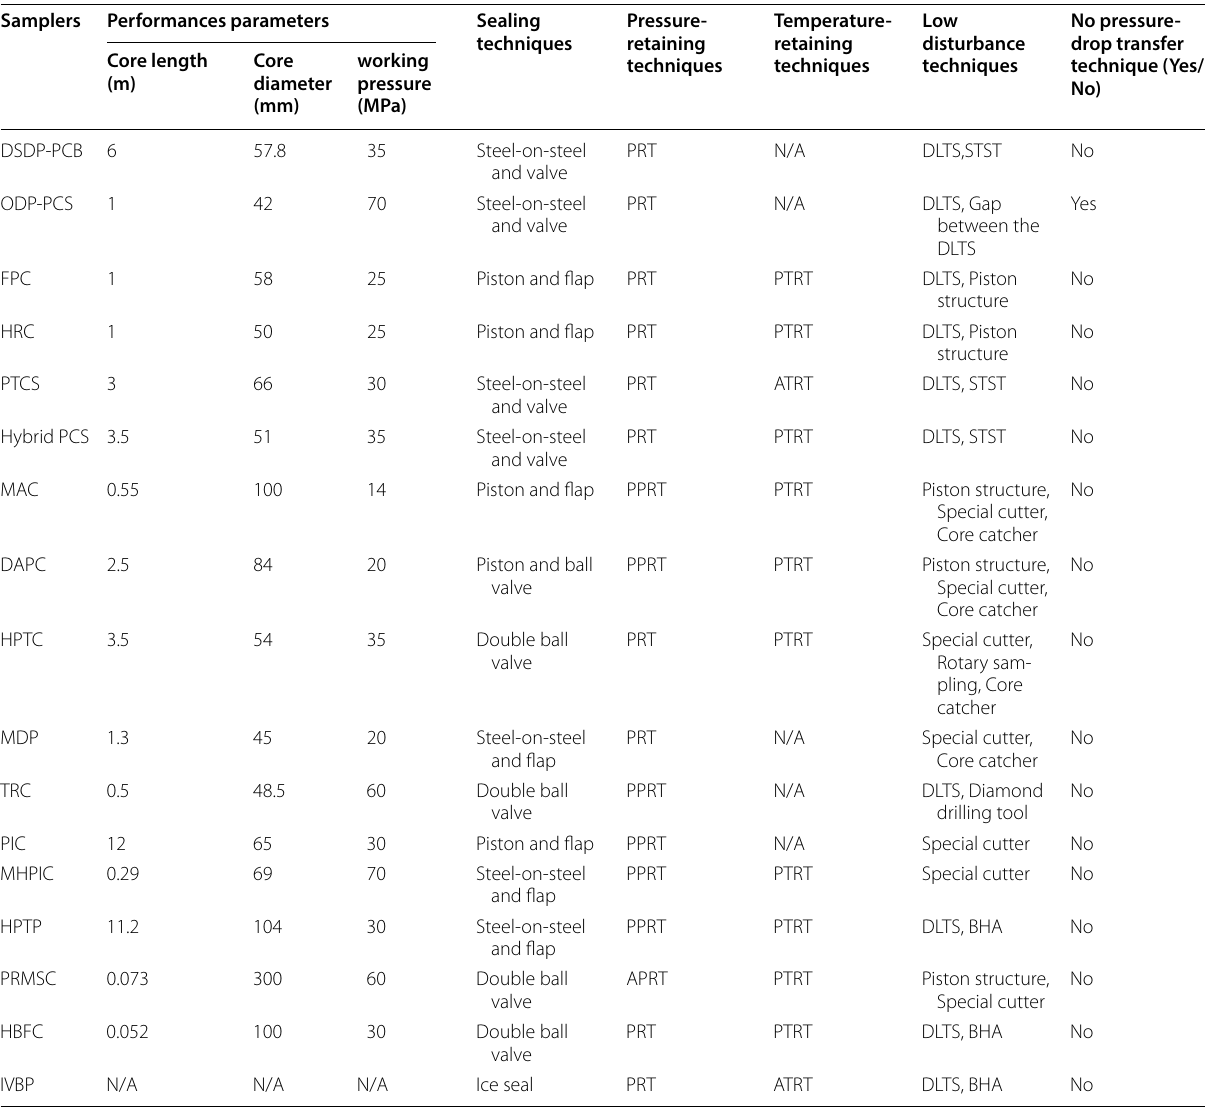
Table 1 Key techniques for sampling deep sea